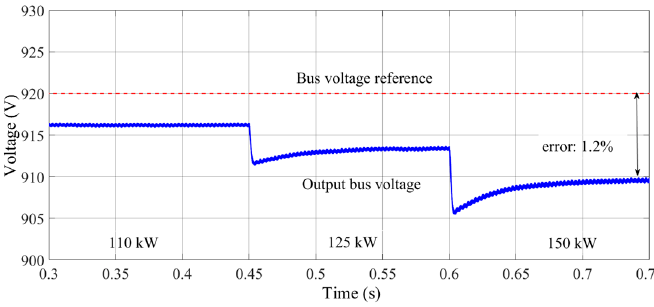
Figure 18. Output voltage V DC with − 10% of tolerance value in passive devices and an increase of resistance in passive and active devices.